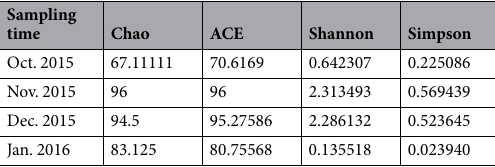
Table 3. Biodiversity index values of Dendroctonus armandi larvae from October 2015 to January 2016.